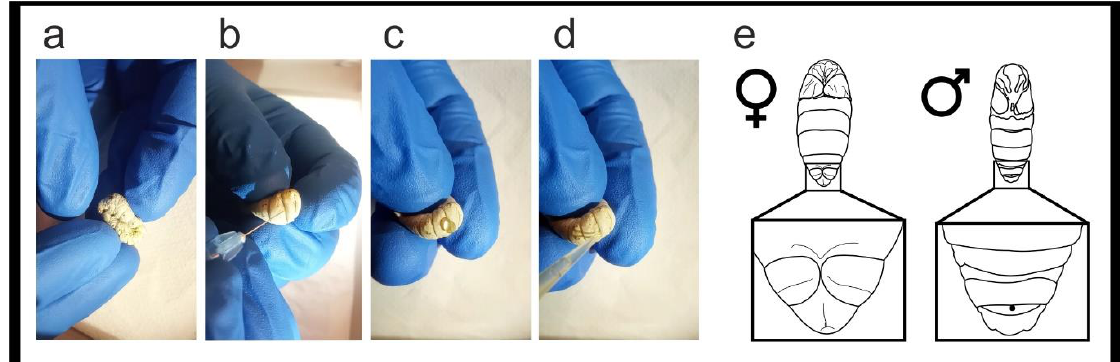
Figure 6. Hemolymph sampling and sexing pupae. To sample larval hemolymph, ( a ) fold the larva, stretch and expose its dorsal surface; ( b ) gently pierce between the dorsal folds of the dermis with a hypodermic needle ( c ) a drop of hemolymph forms at the wound site; ( d ) collect the hemolymph with a micropipette; ( e ) morphological characteristics used to sex pupae, females bear a vertical line on the penultimate (8th) segment, males bear a whole penultimate segment and have a spot on the 9th segment.